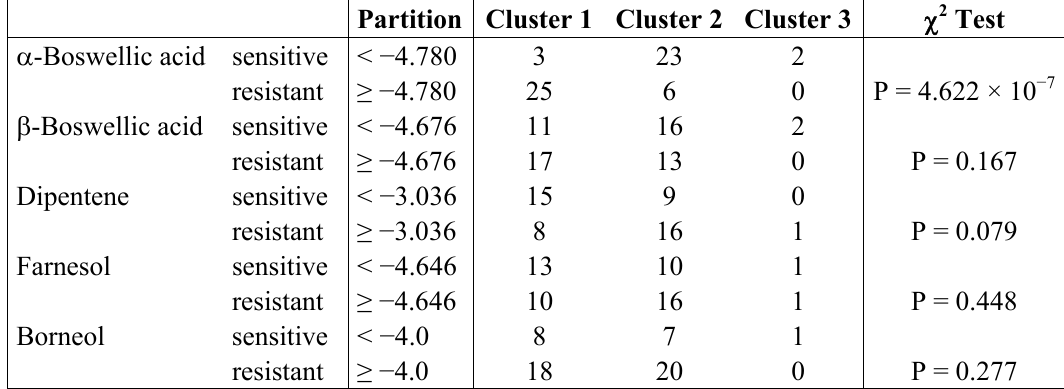
Table 3. Separation of clusters of 60 cancer cell lines obtained by hierarchical cluster analysis for α -boswellic acid shown in Figures 3A in comparison to other phytochemical constituents of Boswellia carterii. The log IC median values (M) of each compound 10 50 were used as cut-off values to define cell lines as being sensitive or resistant. P > 0.05 was considered as not significant ( χ 2 test).